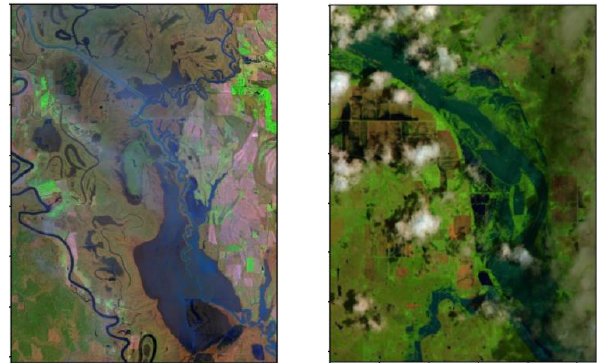
Figure 2. Two of the sixteen post-flood Landsat images used for comparison of the image enhancement algorithms. All images had clouds and haze that reduced their